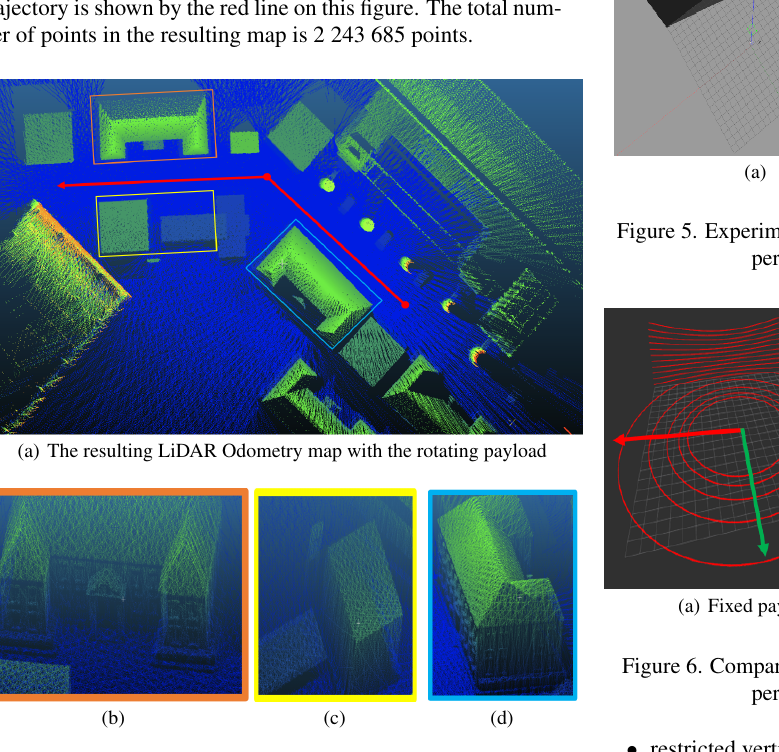
Figure 4. Mapping results given by LiDAR Odometry with the rotating payload. (b), (c) and (d) are exploded views of the rendered map